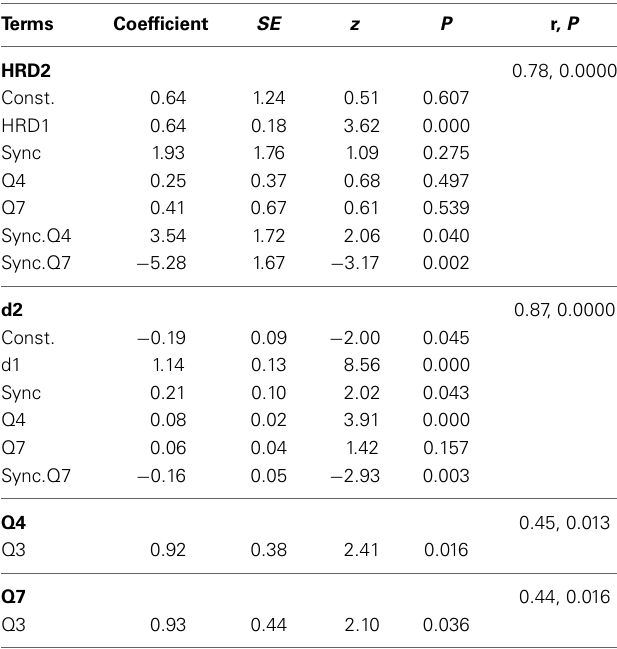
Table 5 | Path Analysis Results Corresponding to Figure